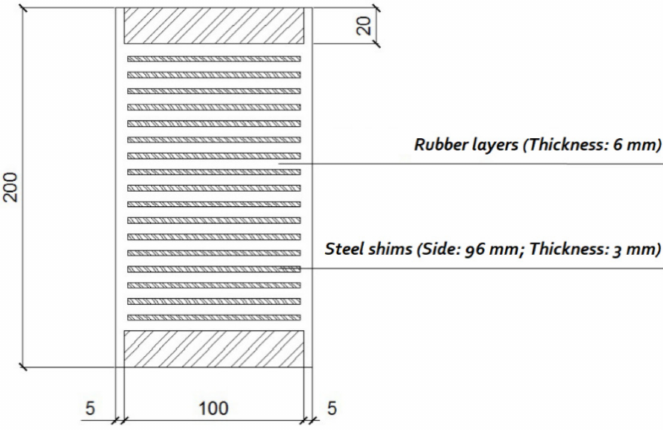
Figure 2. Geometrical characteristics of samples used for the tensile